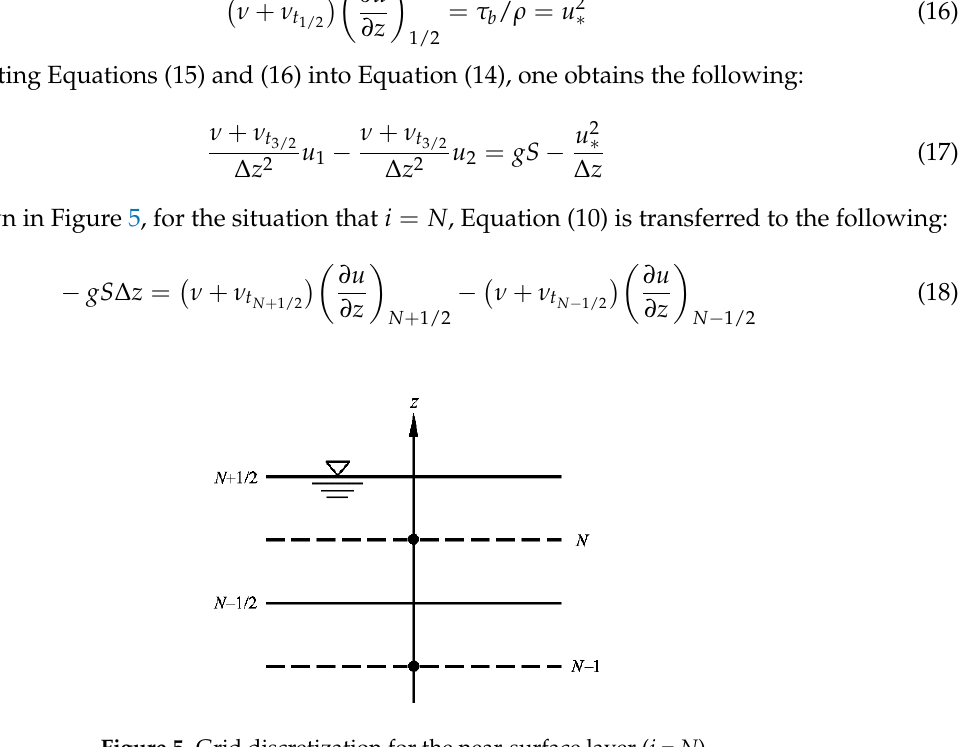
Figure 5. Grid discretization for the near-surface layer ( i = N ).